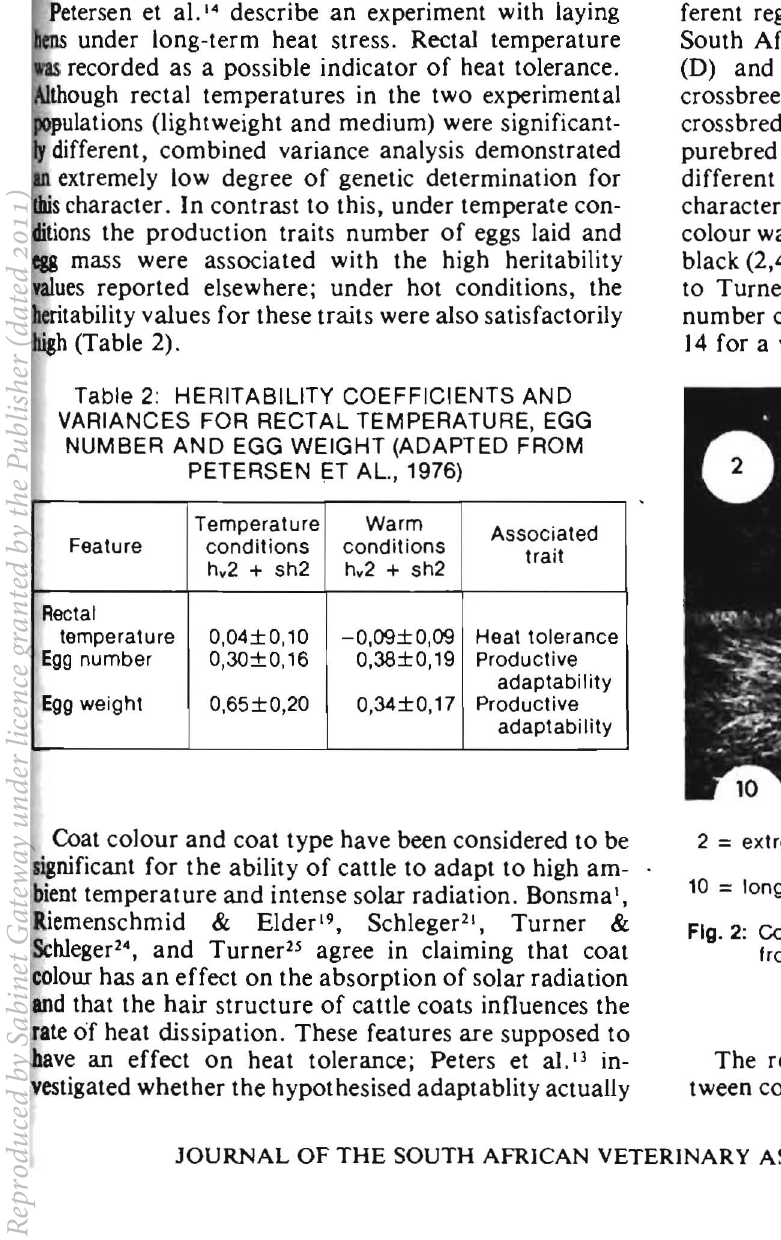
Table 2: HERITABILITY COEFFICIENTS AND VARIANCES FOR RECTAL TEMPERATURE, EGG NUMBER AND EGG WEIGHT (ADAPTED FROM PETERSEN ET AL., 1976)